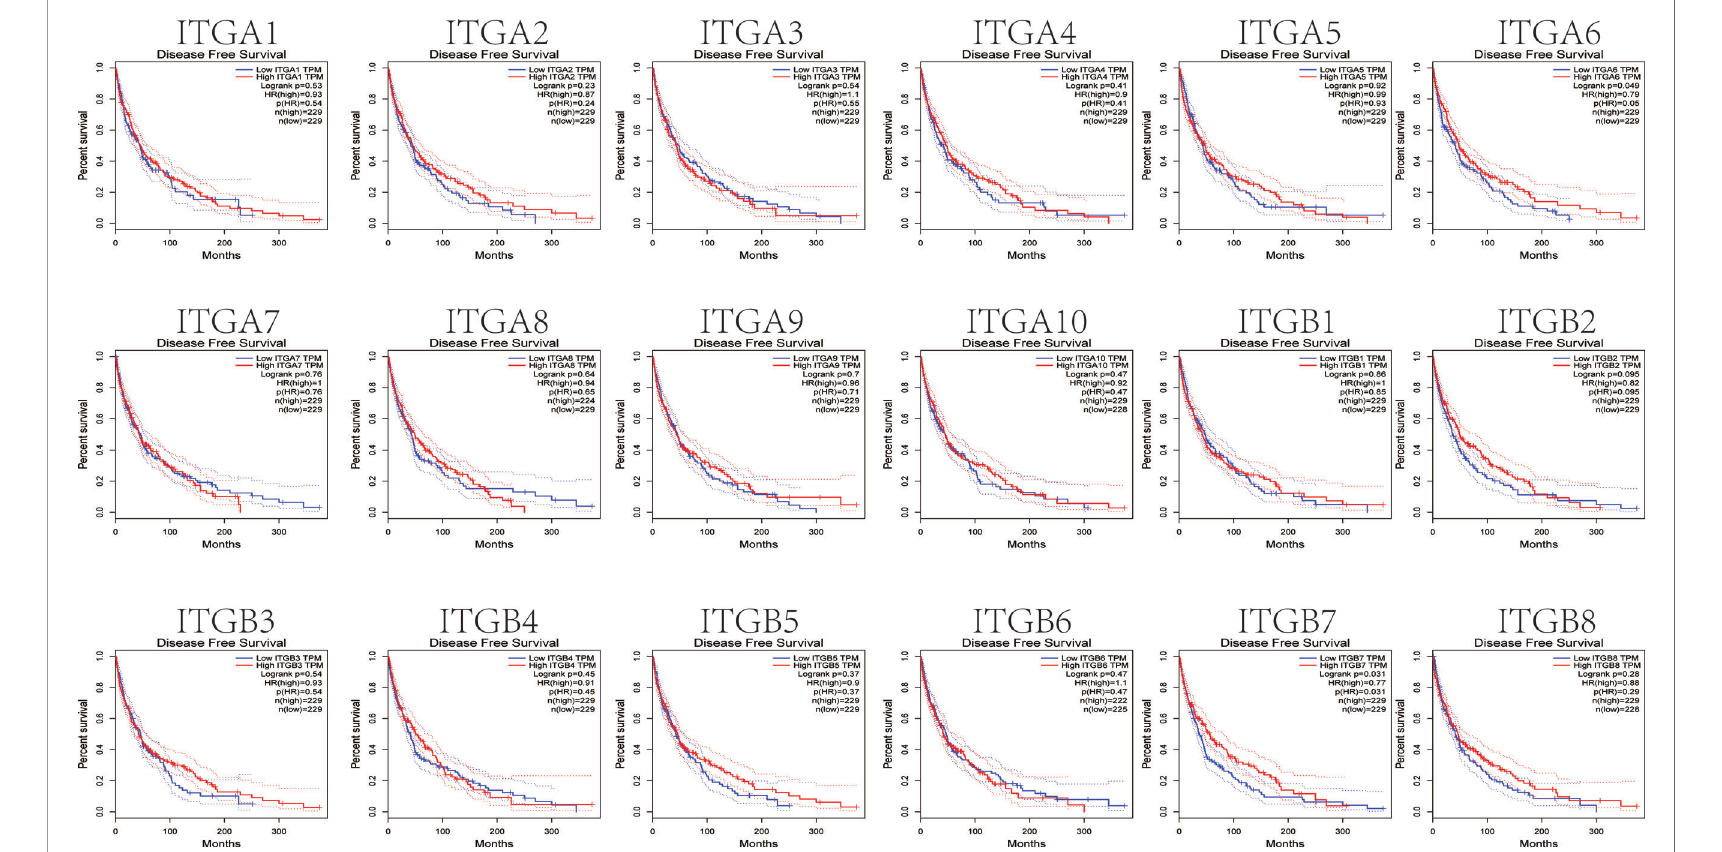
FIGURE 5 | The prognostic value of differentially-expressed integrin subunits in the disease-free survival curve (GEPIA) for SKCM patients. Prognostic analysis was performed using a Kaplan – Meier curve. The p value was set at